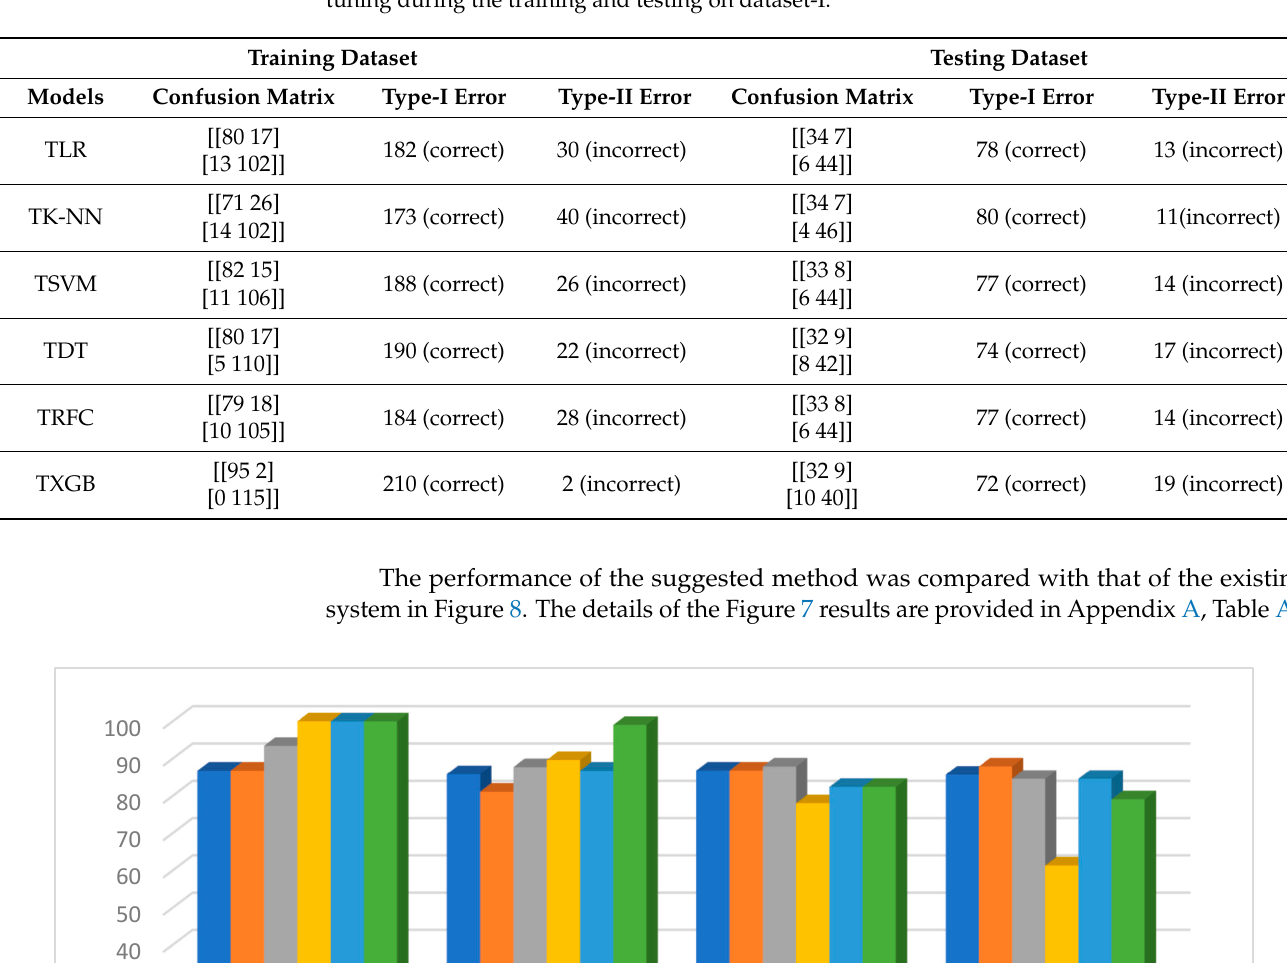
Table 7. The performance evaluation and comparison of the confusion matrix with hyperparameter tuning during the training and testing on dataset-I.